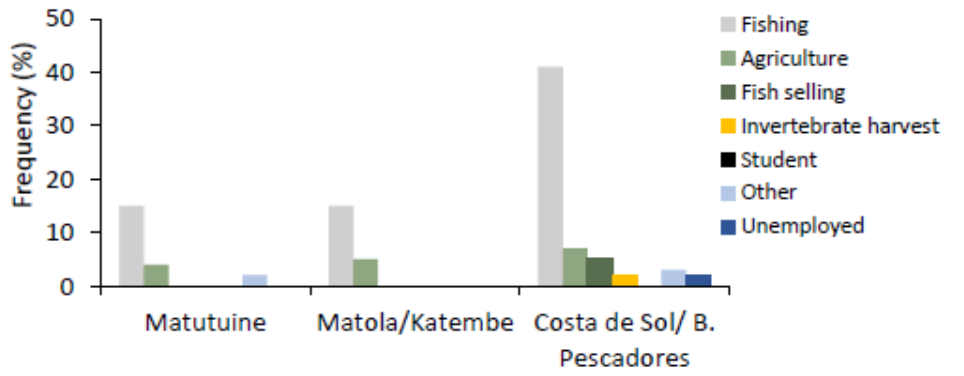
Figure 8. Interviewers’ occupation by location in the surroundings of mangrove forests of Maputo Bay. Table 6. Main ecosystem goods and services derived from mangroves forests in Maputo Bay and Pr í ncipe